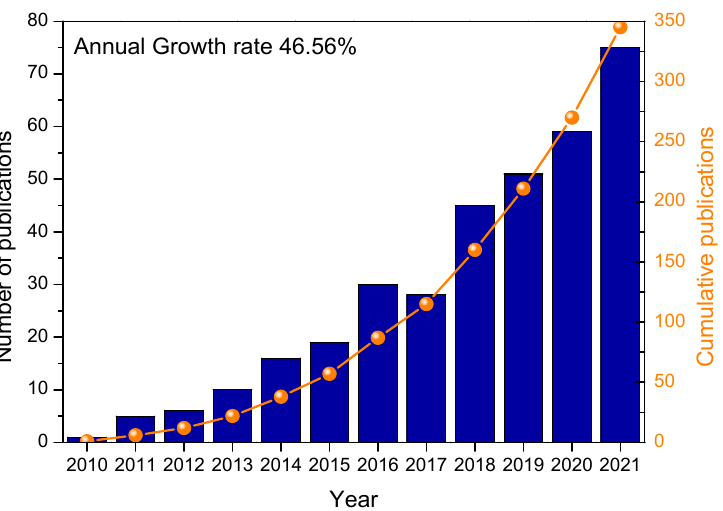
Figure 1. FS annual and cumulative publications from 2010 to December 2021.